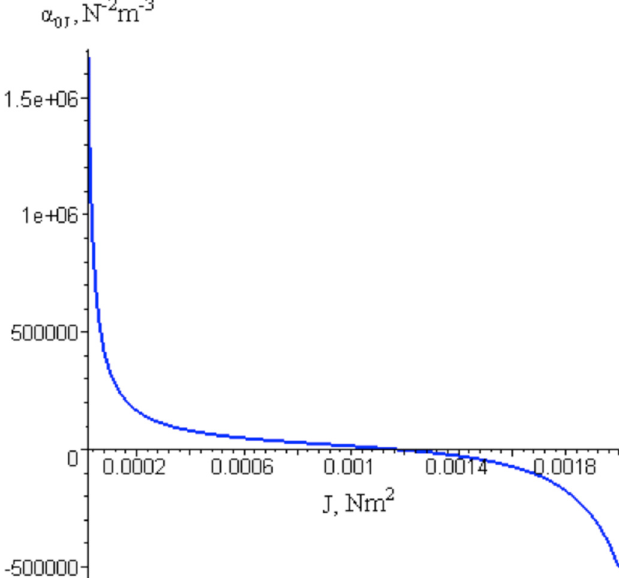
Fig. 7. Characteristics of the change in the coef fi cient of the cumulative impact of the informative parameter and the impact value J on the value D J.